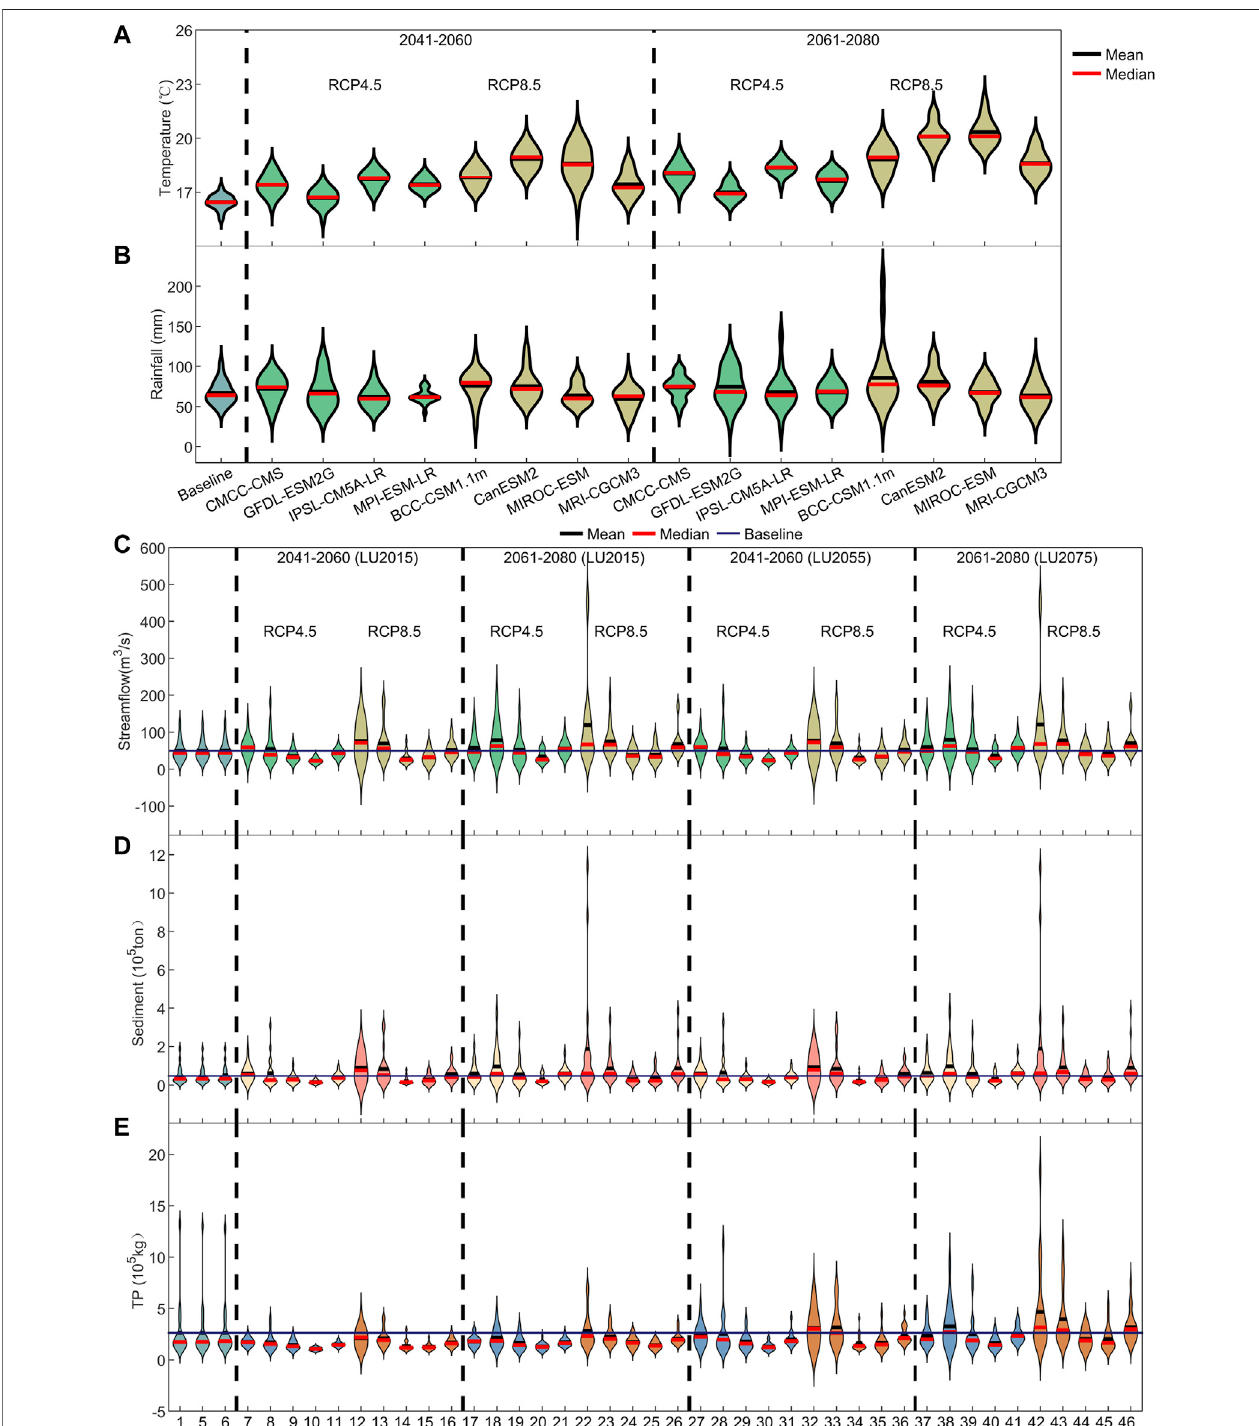
FIGURE 4 | The individual and combined impacts of climate change and land use on the multi-annual average temperature, precipitation, stream fl ow, sediment, and TP under various scenarios (X-axis represents the scenario number corresponding to Table 4 ).